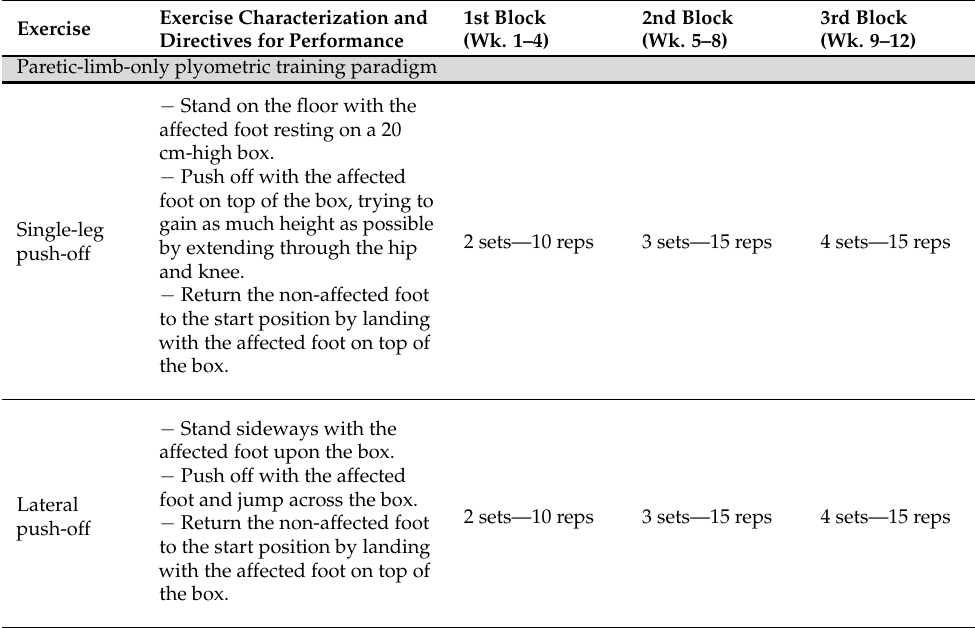
Table 1. Specifics of the paretic-limb-only/double-limb plyometric training paradigms, performance instructions, and training